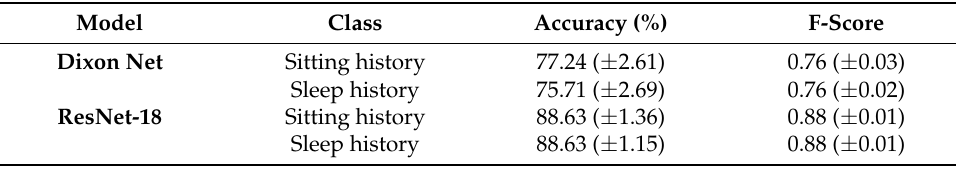
Table 2. Summary performance of each model (across the 5-folds) for each class. Results are presented as the Mean ± SD.